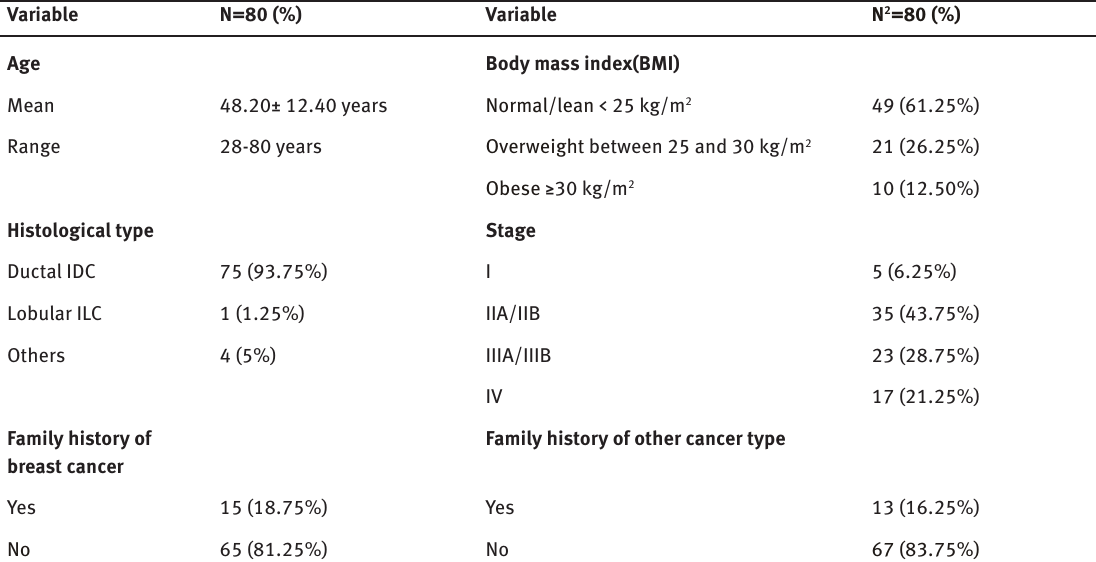
Table 1 : General Characteristics of the case